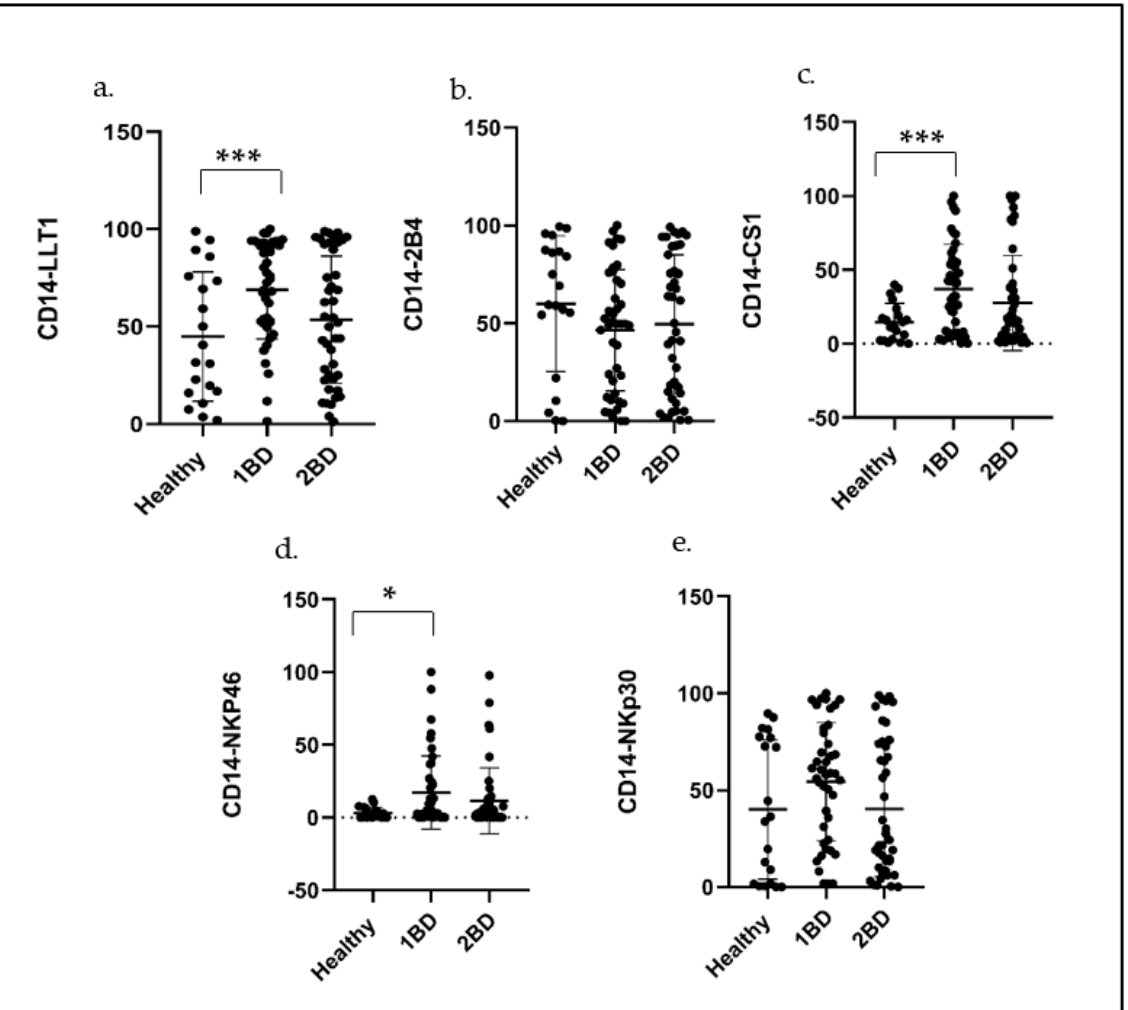
Figure 3. Expression of LLT1, 2B4, CS1, NKp30 and NKp46 on monocytes (CD14+) of ALL subjects compared to healthy subjects. ( a – e ) Flow cytometry analysis exhibit percentage of positive cells for the indicated receptors in CD14+ monocytes in ALL subjects and healthy subjects at diagnosis and post–induction chemotherapy. 1BD, first blood draw indicates sample obtained at diagnosis (day 0). 2BD, second blood draw indicates sample obtained at the end of induction chemotherapy (day 29). * p < 0.05,*** p < 0.005.